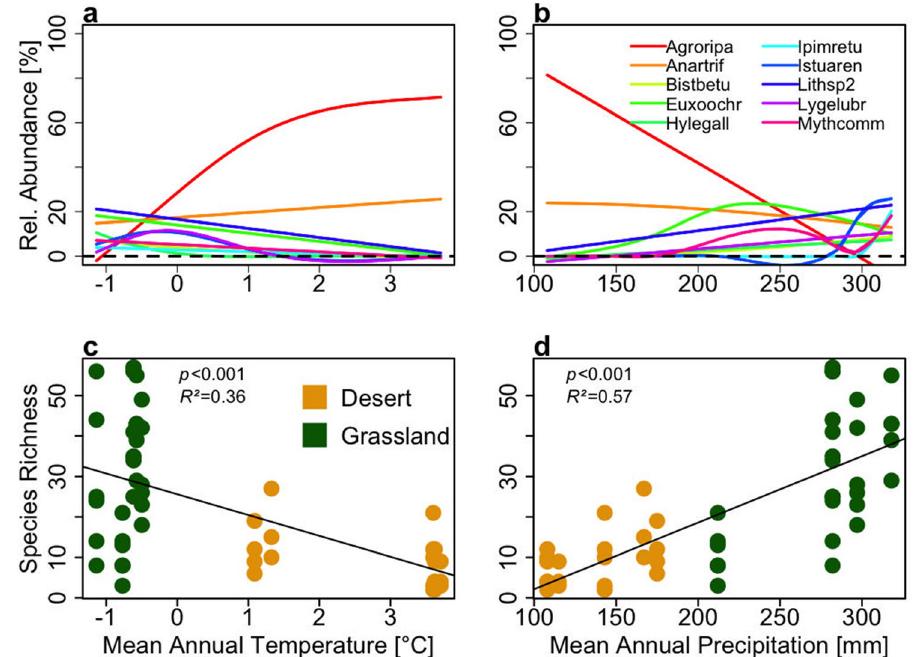
Figure 3. Species relative abundance and species richness impacted by environmental variables. X axes titles are printed only for the lower graphs. GAM shows ( a ) the relative abundance vs. mean annual temperature and ( b ) the relative abundance vs. mean annual precipitation. The general linear regression model demonstrates that moth species richness is impacted by ( c ) mean annual temperature and ( d ) mean annual precipitation. Species abbreviations: Agrotis ripae (Agroripa), Anarta trifolii (Anartrif), Biston betularia (Bistbetu), Euxoa ochrogaster (Euxoochr), Hyles gallii (Hylegall), Ipimorpha retusa (Ipimretu) Isturgia arenacearia (Istuaren), Lithostege sp2